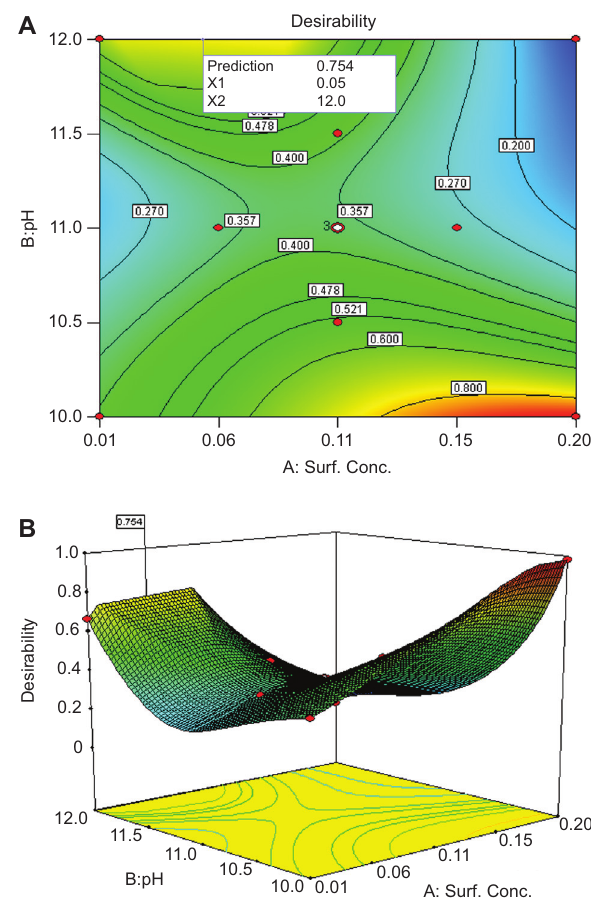
Figure 11 Desirability plot for the obtained mathematical model in (A) 2D view and (B) 3D view.